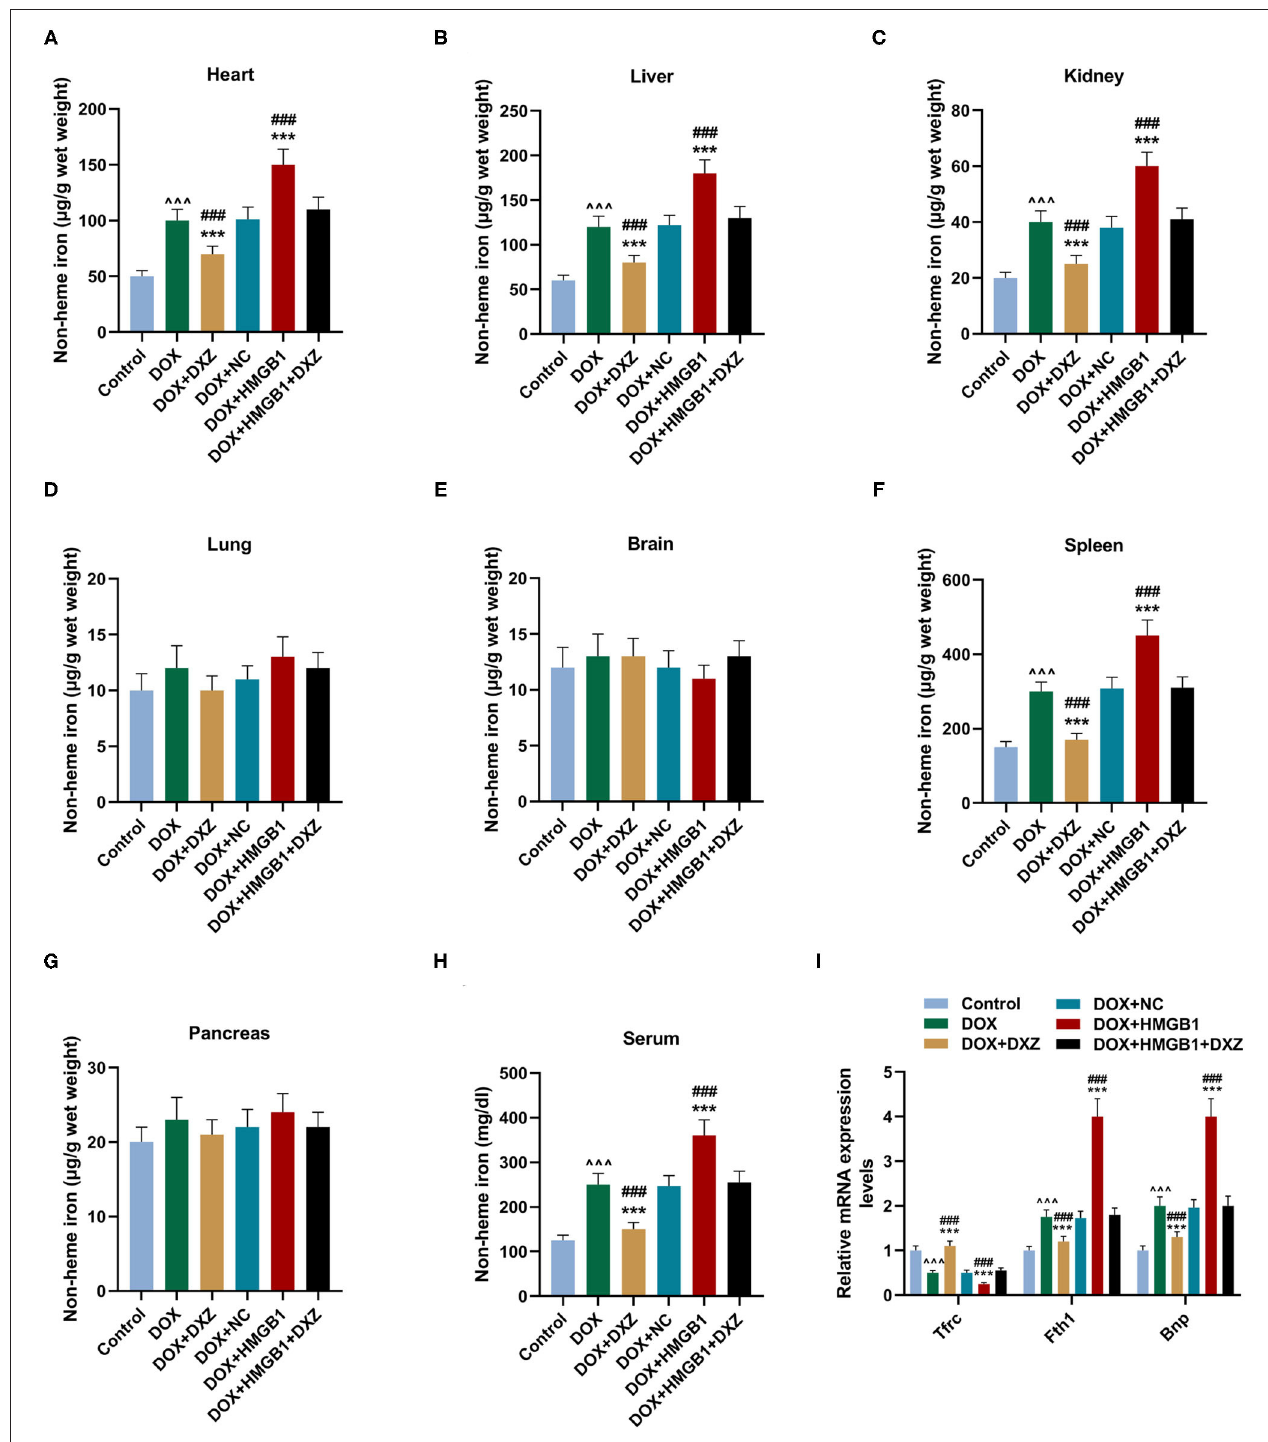
FIGURE 5 | The levels of non-heme iron in the indicated organs and serum of rats. (A–H) The levels of non-heme iron in the indicated organs and serum of rats from different groups at 4 days after the treatment was detected by a commercial kit. Ten rats were used in each group. (I) The cardiac mRNA expression levels of TFRC, FTH1, and BNP were quantified by qRT-PCR. Ten rats were used in each group. ∧∧∧ P < 0.001 vs. control. *** P < 0.001 vs. DOX. ### P < 0.001 vs. DOX + HMGB1 + DXZ. Each experiment was repeated three times.